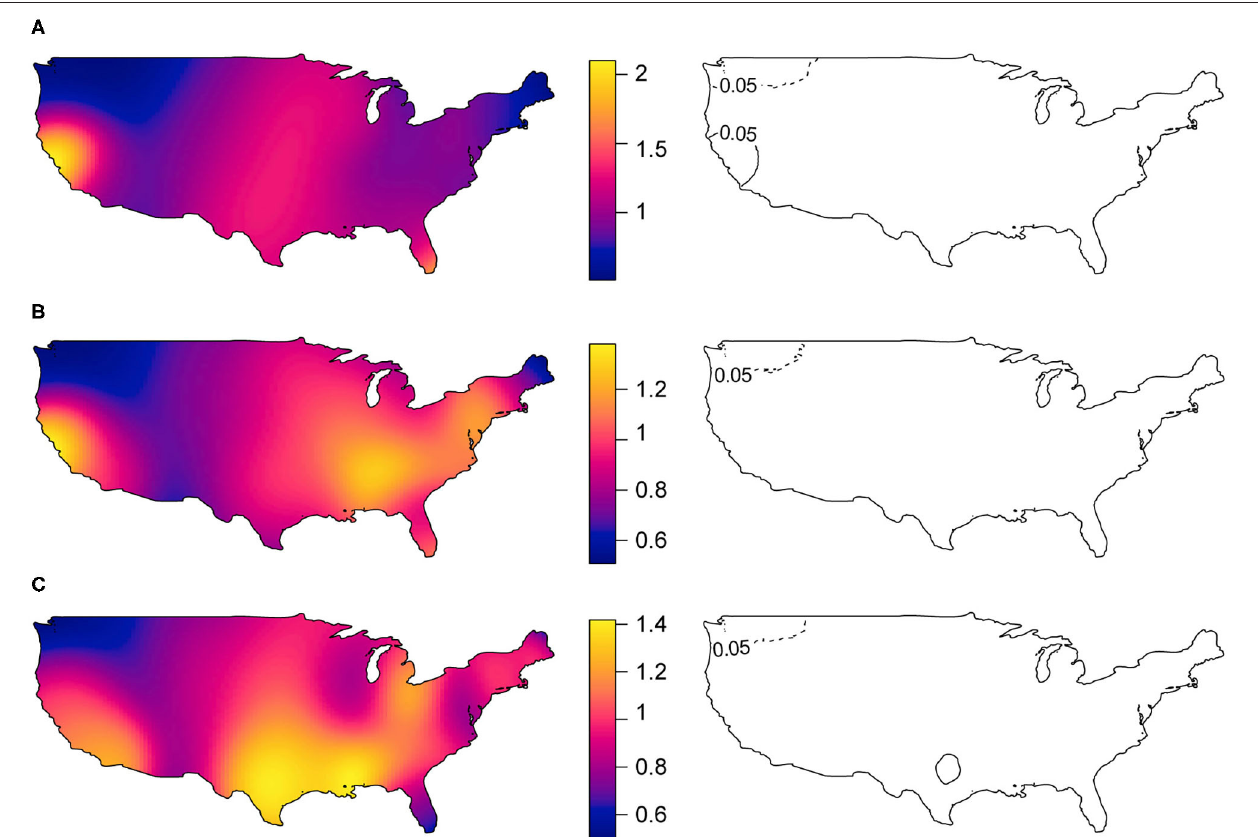
FIGURE 2 | Spatial distribution of myositis subgroup relative prevalence of cases (in left panels) and statistically significant areas with excess and lower prevalence of cases (in right panels). (A) Dermatomyositis vs. Polymyositis cases, (B) Dermatomyositis vs. Inclusion body myositis cases, and (C) IIM cases with lung disease vs. IIM cases without lung disease. Areas with black solid lines and with dotted lines showing statistically significant increased and decreased prevalence of cases at 5% level-of-significance,